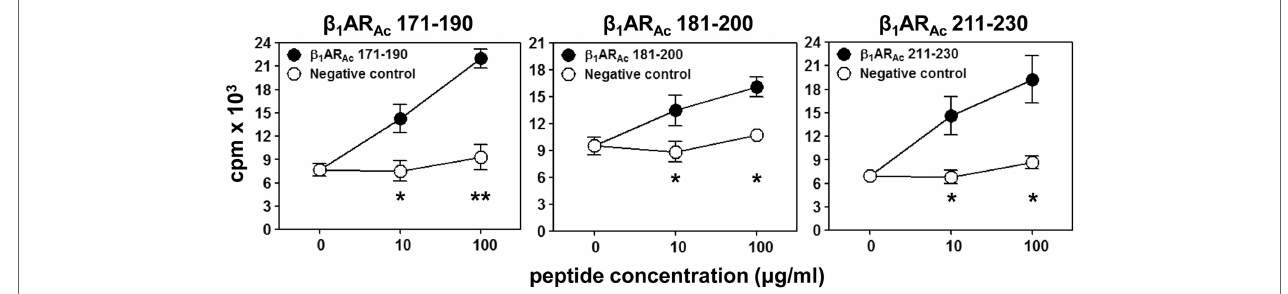
FigUre 1 | T cell responses induced by β 1 AR Ac peptides. Lymph node cells (LNCs) obtained from animals immunized with β 1 AR Ac 171–190, β 1 AR Ac 181–200, and β 1 AR Ac 211–230 were restimulated with or without the corresponding peptides and RNase 43–56/HEL 46–61 (negative control) for 2 days. After pulsing with 3 [H]-thymidine for 16 h, proliferative responses were measured as cpm. Mean ± SEM values derived from three to four individual experiments, each involving three to eight mice are shown. * P < 0.05 and ** P < 0.01 vs. negative controls.